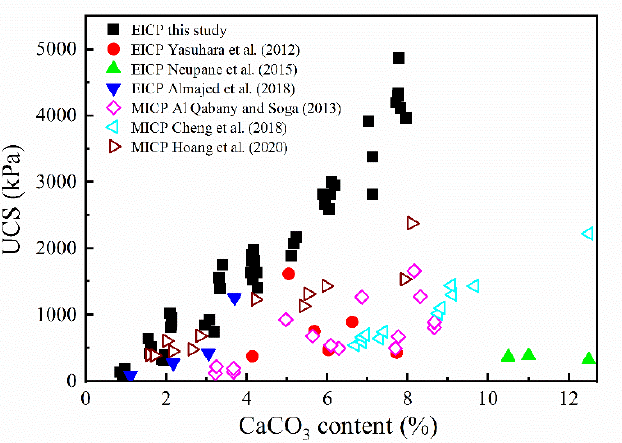
Figure 8. UCS of the present EICP results versus previous EICP and MICP data. Figure 13. UCS of the present EICP results versus previous EICP and MICP data (Yasuhara et al. [31]; Neupane et al. [35]; Almajed et al. [13]; Al Qabany and Soga, [45]; Cheng et al. [23]; Hoang et al. [34]).